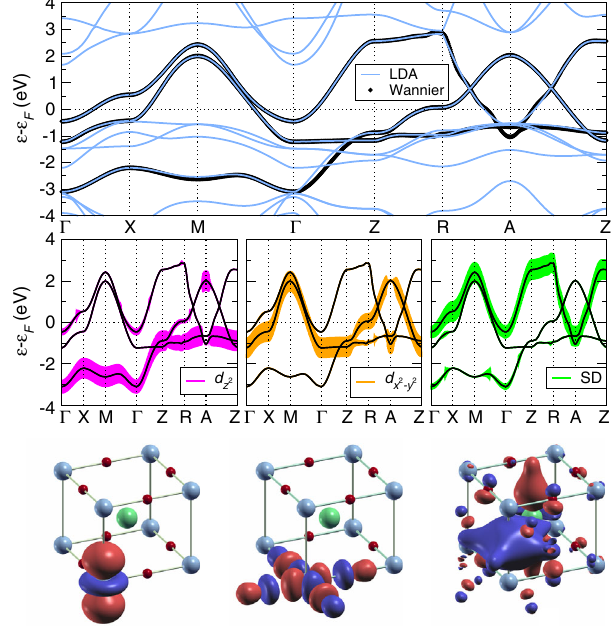
FIG. 6. Wannier properties of the three-band model for IL nickelate. Top panel: Low-energy LDA bands of NdNiO 2 (light blue) and Wannier dispersion (black) along high-symmetry lines in the Brillouin zone. Middle panels: Orbital weights on the Wannier dispersion (i.e., fat-band picture); from left to right: Ni- d , Ni- d , and SD orbital. Bottom panels: Constant-value z 2 x 2 − y 2 surfaces of the three Wannier orbitals (aligned as in the middle